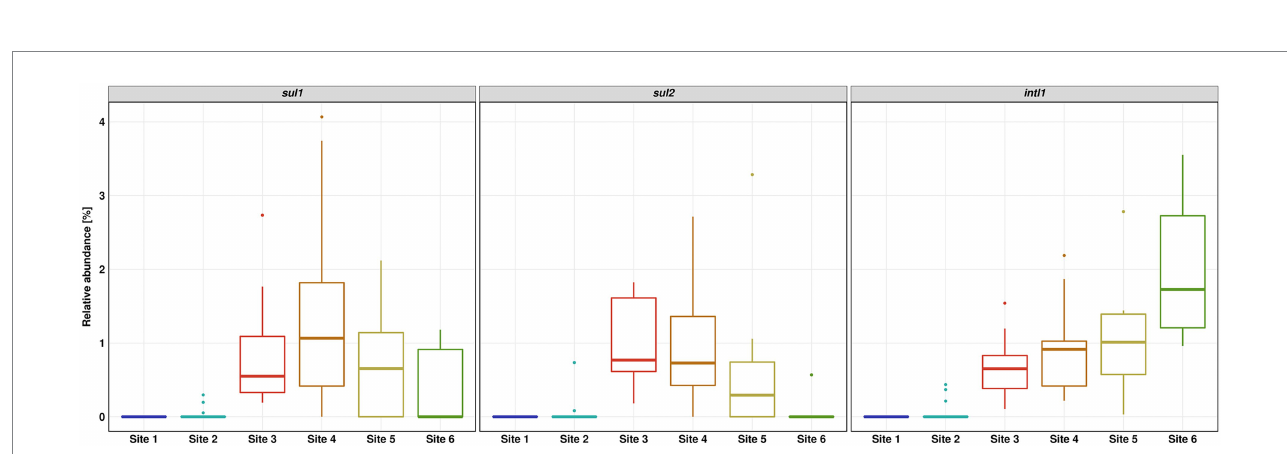
FIGURE 5 Relative abundance of sul1 , sul2 and intI1 over 16S rRNA gene determined by quantitative real-time PCR. Number of replicates ( n ) =